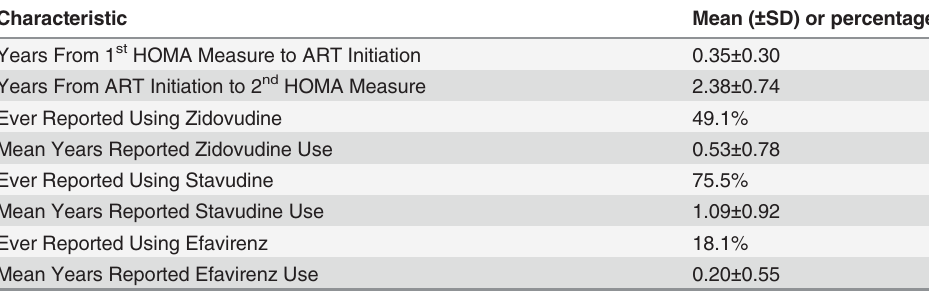
Proportions of HIV+ ART initiators: 26.7% used AZT, 62.5% used D4T, 89.1% used NRTI total and 1.3% used NRTI other than AZT or